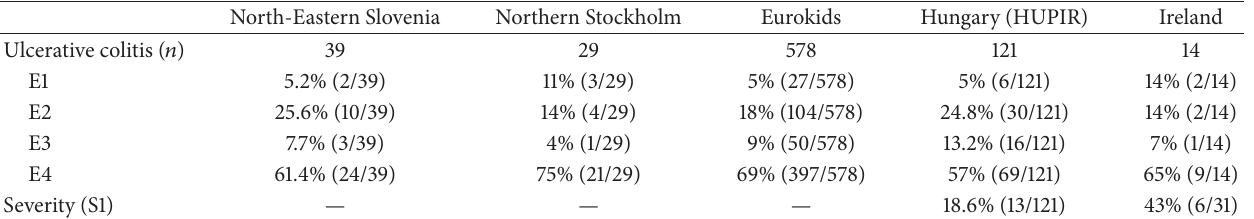
Table 5: Paris Classification of ulcerative colitis patients in population-based studies in Europe [3, 32, 34, 57, 58]. North-Eastern Slovenia Northern Stockholm Eurokids Hungary (HUPIR) Ireland Ulcerative colitis ( 𝑛